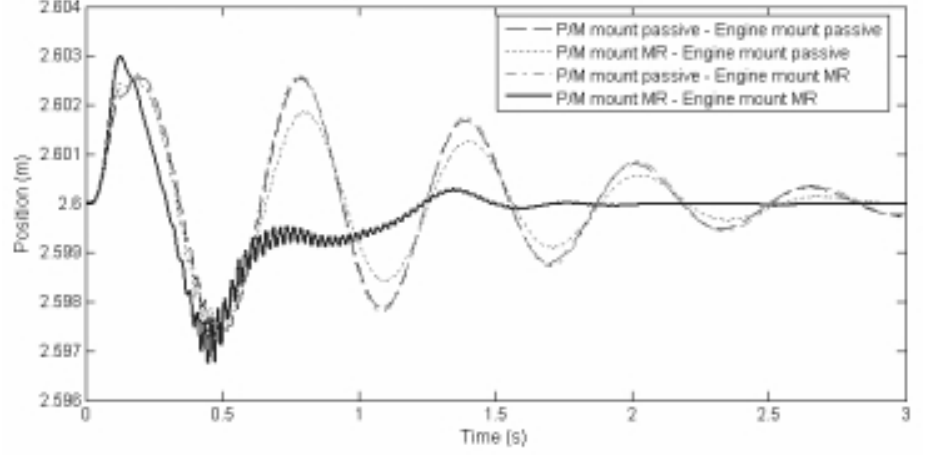
Fig. 5. Position of the hydraulic subsystem (HSS) in time domain.